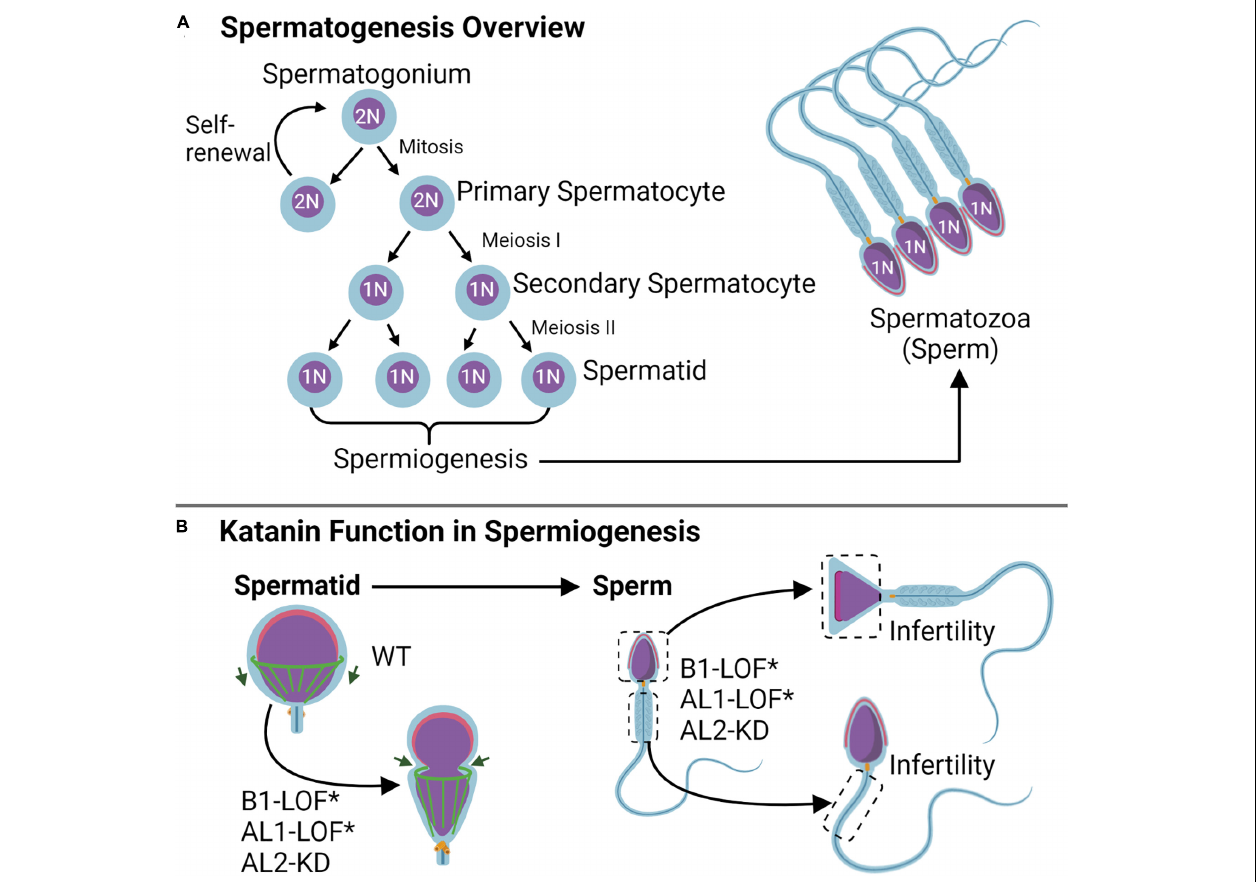
FIGURE 5 | Katanin function in gametogenesis. (A) Spermatogenesis overview. During spermatogenesis, the spermatogonium either experiences self-renewal or undergoes two rounds of meiosis to become a spermatid; spermiogenesis occurs after the second meiotic completion and consists of the shaping of the sperm head and tail. (B) During spermiogenesis, katanin B1 and AL2 subunits work in shaping the manchette (green) for purposes of head shaping and tail formation. Knockdown (KD) of either AL1 or AL2 as well as B1 loss of function (LOF) by means of the Taily mutation in mice (KATNB1 Taily / Taily ) leads to sperm head and tail shaping defects that cause